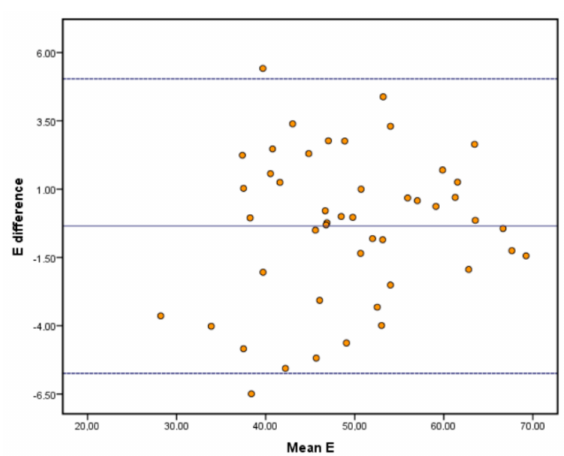
Figure A1. Bland-Altman plot flexion ROM.